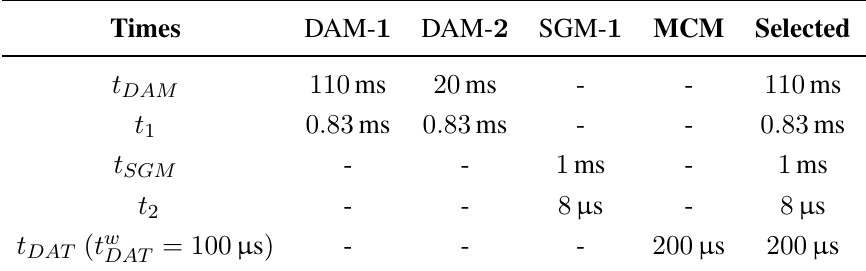
Table 1. Estimated times for the DAMs and SGMs, based on the variables presented in Equation (2).